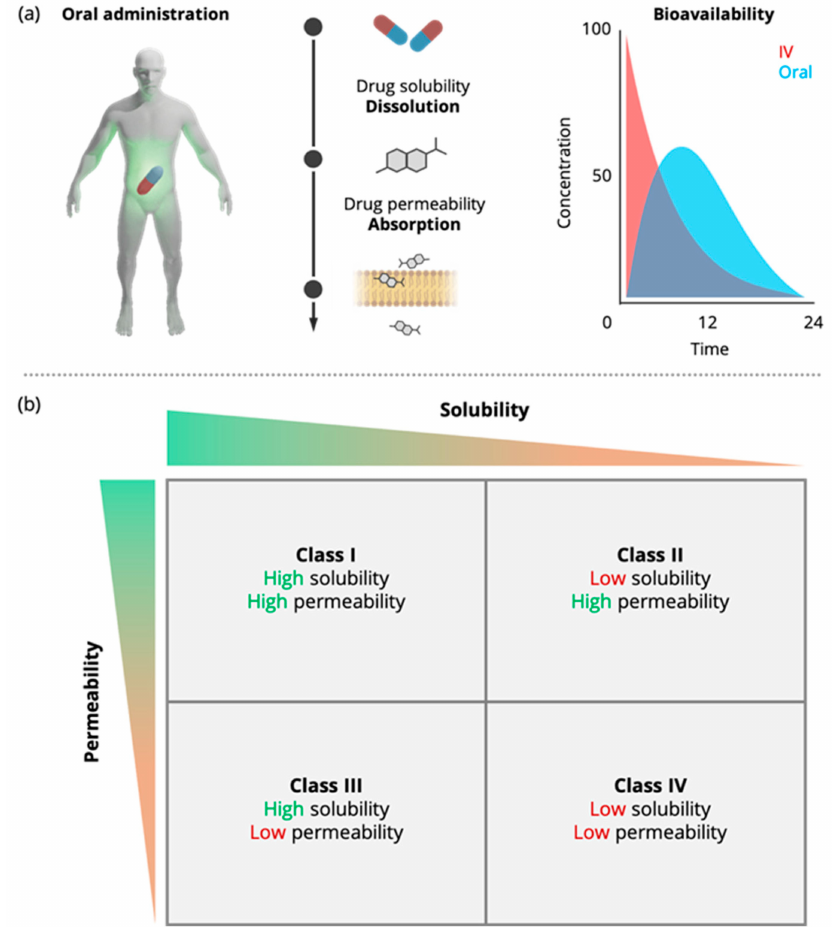
Figure 1. Schematic representation of the interplay of solubility and permeability in oral drug absorption ( a ) and the Biopharmaceutics Classification System (BCS) introduced by Amidon et al. in 1995 [5] ( b ). Once a dosage form is administered orally, it undergoes dissolution and drug molecules are then absorbed through the gastrointestinal (GI) tract through the process of permeation. The fraction dose absorbed, %A, depends mainly on the drug’s aqueous solubility and its permeability through biomimetic